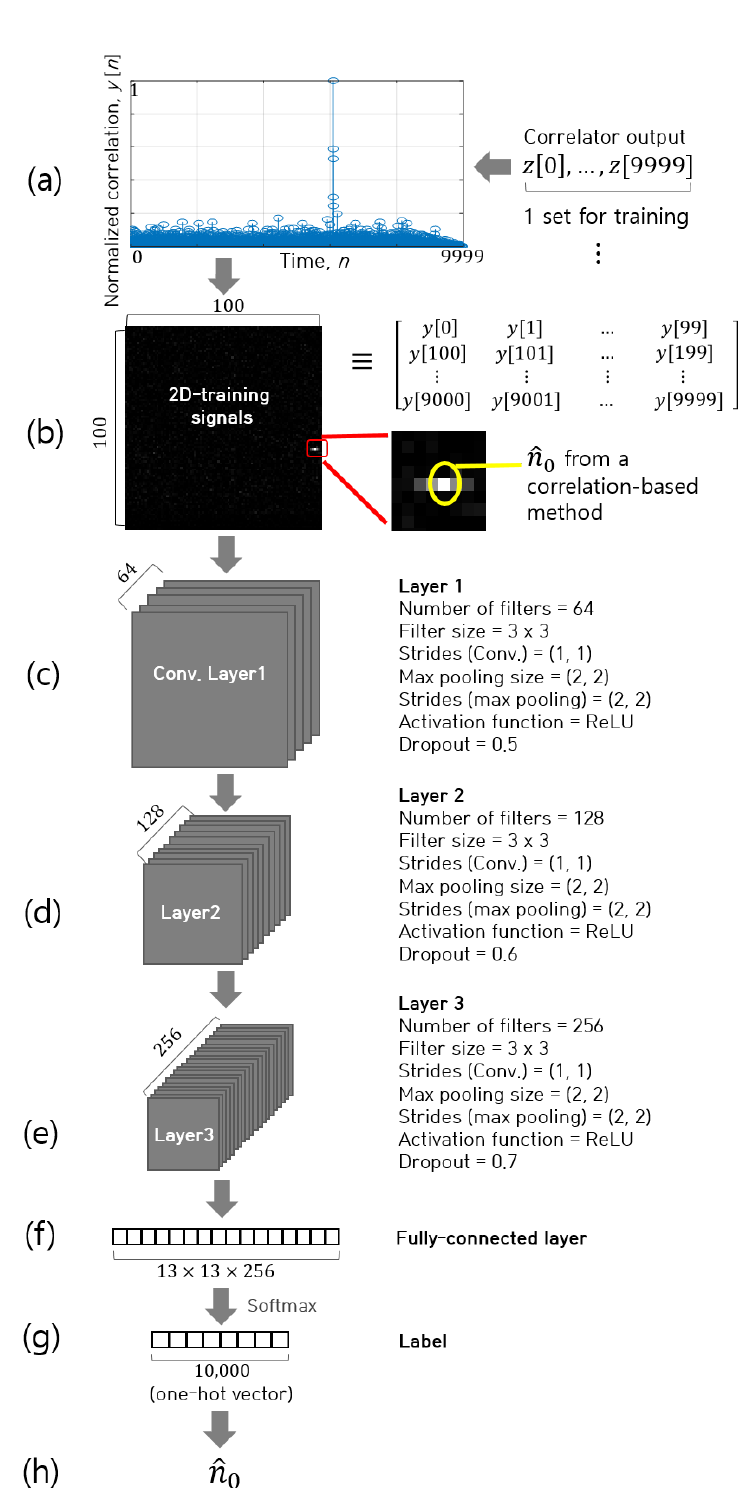
Figure 5. Diagram of the proposed CNN-based synchronization block in Figure 5, when W = 10,000. ( a ) Correlation output normalization. ( b ) 2D-training signal generation. ( c ) Convolutional layer 1. ( d ) Convolutional layer 2. ( e ) Convolutional layer 3. ( f ) Fully-connected layer. ( g ) Label vector. ( h ) Estimate of packet arrival